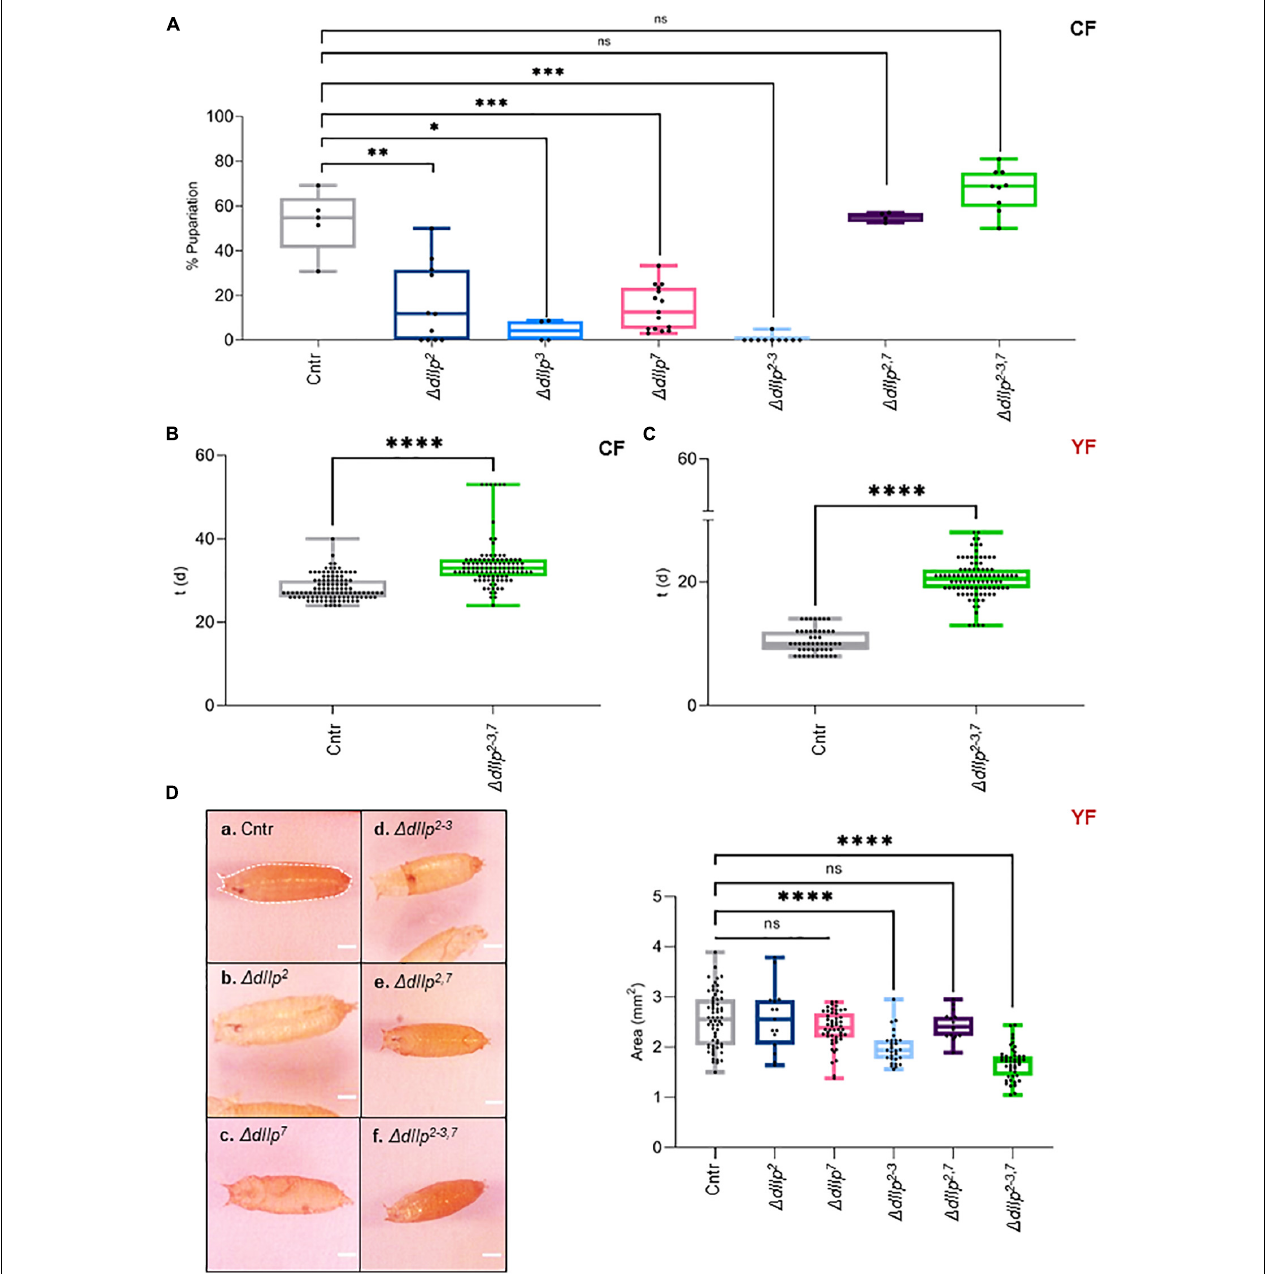
FIGURE 2 | DIlp7 regulates larval development on yeast-free corn food. (A) Plotted is the larval survival on corn food (CF) at 20 ◦ C. Shown are the percentage of formed pupae from genetic controls ( mCherry:FOXO , Cntr) and different dIlp mutants as indicated on the X -axis. Box-plot, each dot represents one experiment with minimum n = 10 individual larvae. Significance calculated by Mann-Whitney’s test, Cntr vs. (cid:49) dIlp 2 : p = 0.0025 ∗∗ ; Cntr vs. (cid:49) dIlp 3 : p = 0.0159 ∗ ; Cntr vs. (cid:49) dIlp 7 : p = 0.0002 ∗∗∗ ; Cntr vs. (cid:49) dIlp 2 − 3 : p = 0.0003 ∗∗∗ ; Cntr vs. (cid:49) dIlp 2 , 7 : p > 0.9999 ns ; Cntr vs. (cid:49) dIlp 2 − 3 , 7 : p = 0.0889 ns . For crude data, see Supporting informations_Raw data_Main figures/ Supplementary Figure 2A . (B,C) Shown as box-plots are the larval developmental speed (in days, d) on corn food (CF, B ) or yeast food (YF, C ) at 20 ◦ C. Compared are genetic controls ( mCherry:FOXO , Cntr) with (cid:49) dIlp 2 − 3 , 7 triple mutants. For crude data, see Supporting informations_Raw data_Main figures/ Supplementary Figures 2B,C . Significance calculated by Mann-Whitney’s test, p < 0.0001 ∗∗∗∗ . (D) Shown are photographs (a–f) of pupae formed from larvae kept on yeast food (YF) at 20 ◦ C. Pupal areas (indicated in a., broken line) of genetic controls ( mCherry:FOXO , Cntr) and different dIlp mutants were measured and plotted on a box-plot (one black dot = one pupa). Significance calculated by Mann-Whitney’s test, Cntr vs. (cid:49) dIlp 2 : p = 0.9366 ns ; Cntr vs. (cid:49) dIlp 7 : p = 0.1017 ns ; Cntr vs. (cid:49) dIlp 2 − 3 , (cid:49) dIlp 2 − 3 , 7 : p < 0.0001 ∗∗∗∗ ; Cntr vs. (cid:49) dIlp 2 , 7 : p = 0.5218 ns . For crude data, see Supporting informations_Raw data_Main figures/ Supplementary Figure 2D